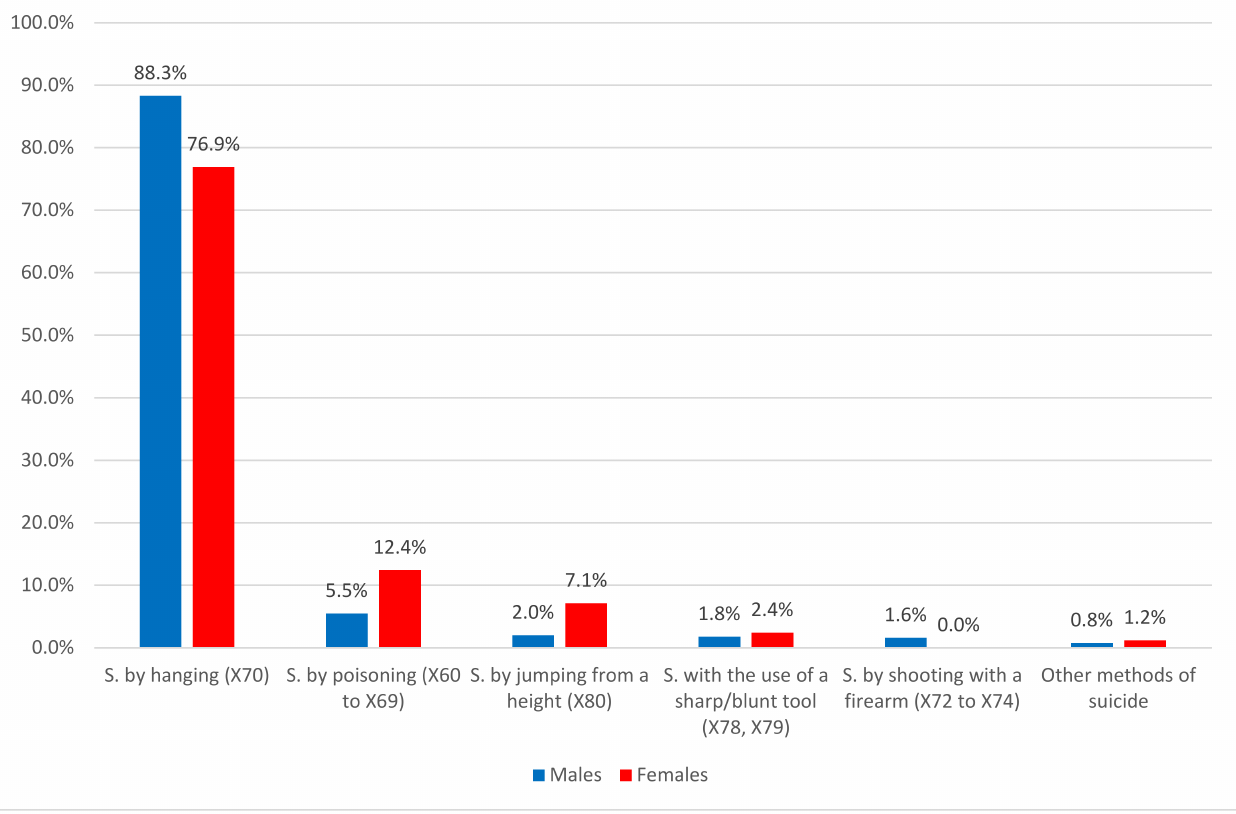
Figure 3. Suicide methods among adults aged 65 or older in Poland by sex, 2018. Source: Author’s own calculations based on data from the Polish Central Statistical Office (GUS); S. =